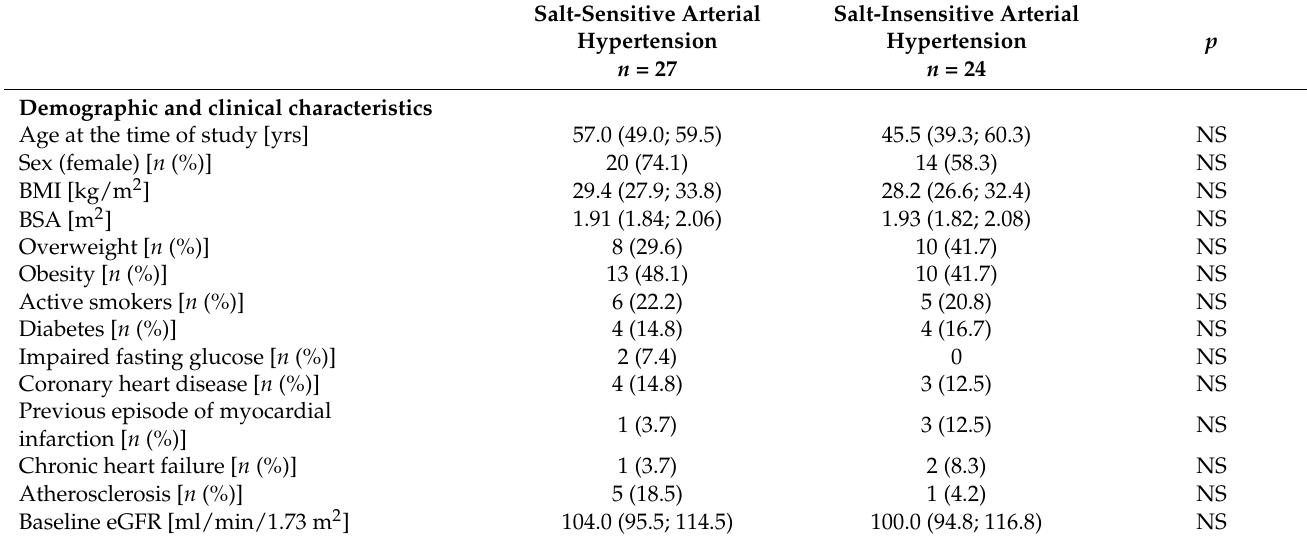
Table 1. Basic characteristics of both study groups (salt-sensitive and salt-insensitive patients with primary hypertension). Salt-Sensitive